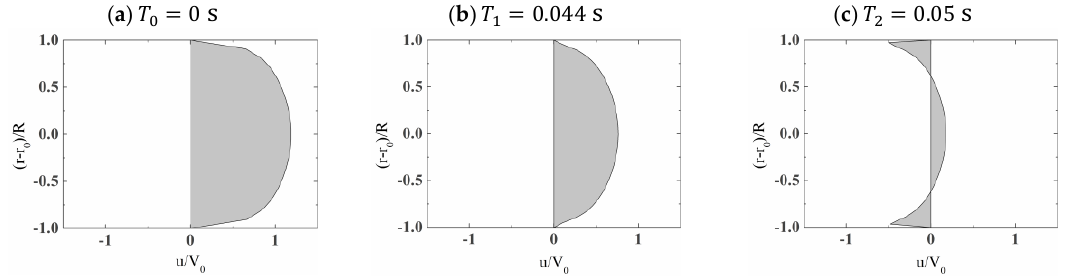
Figure 10. Axial velocity distribution at different time ( 𝑇 0 = 0 s , 𝑇 1 = 0.044 s , and 𝑇 2 = 0.05 s ) of the S1 monitoring point. Water 2018 , 10 , x FOR PEER REVIEW